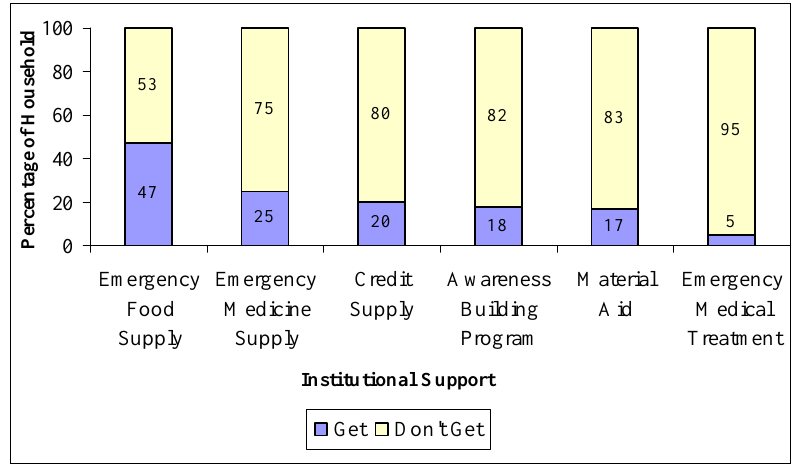
Figure 6. Distribution of households according to availability of supports. Source: field survey.